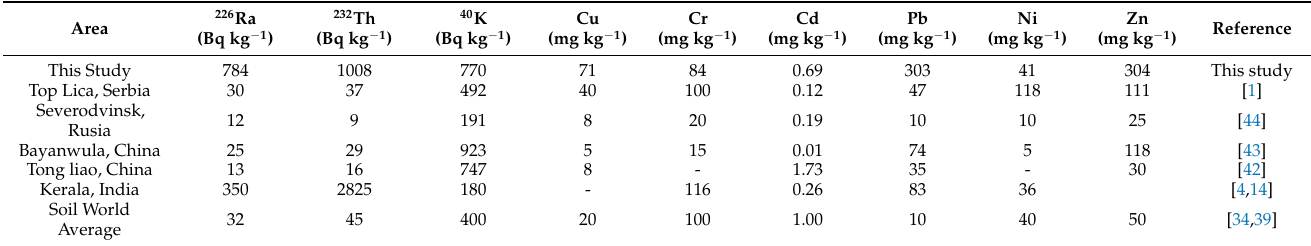
Table 3. The comparison of heavy metal and radionuclide concentrations in the Mamuju area and several regions in the